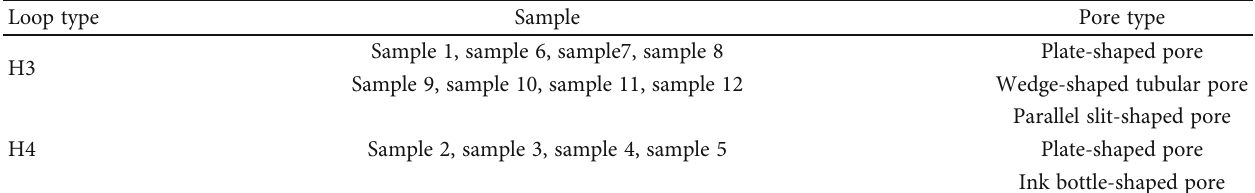
adsorption-desorption isotherms. 2